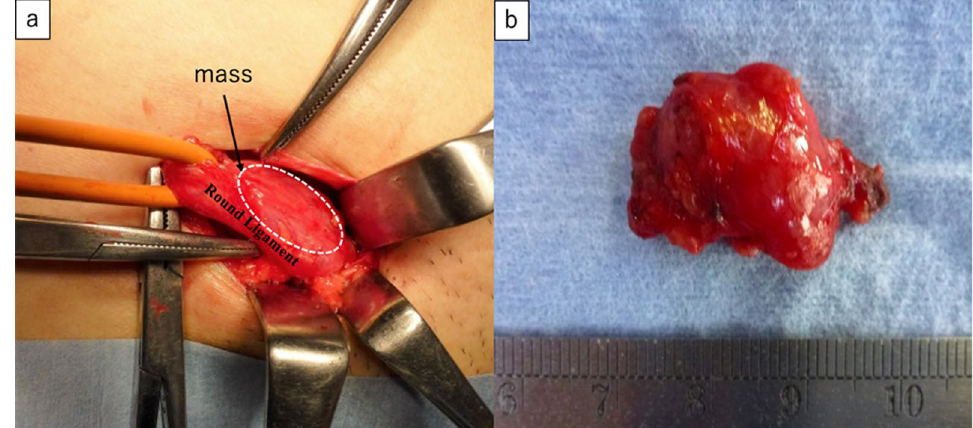
Fig. 3 a Boundary between the mass and the surrounding tissue was well‑defined. b Mass was removed without